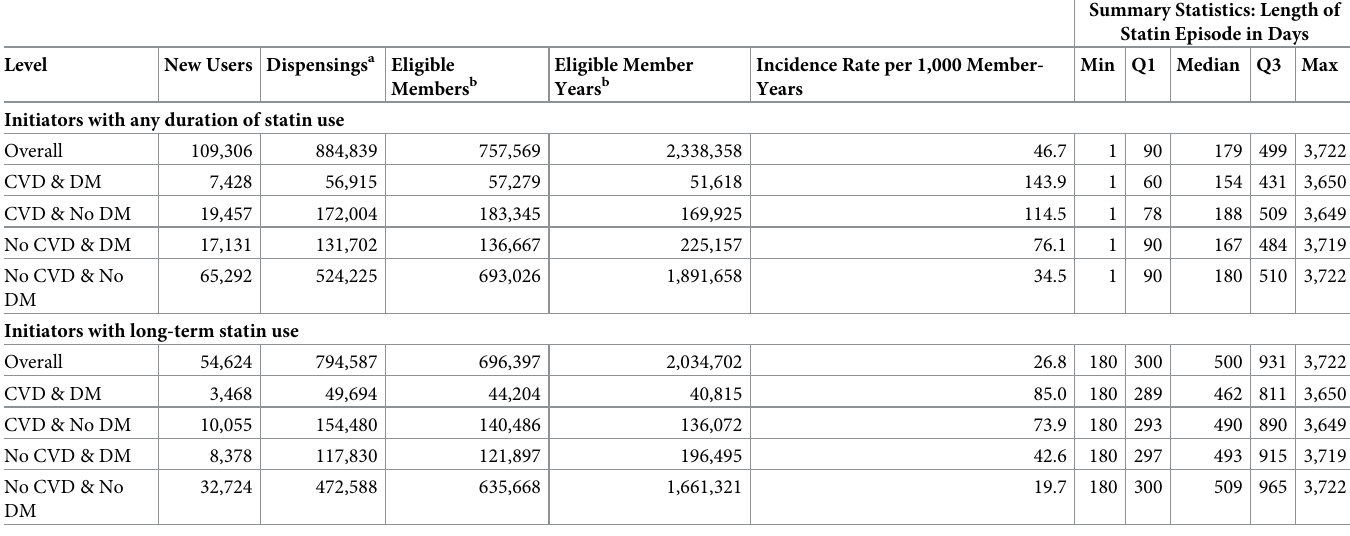
Table 1. Statin initiation among older adults aged > 75 years with and without cardiovascular disease and diabetes mellitus, NIH Collaboratory Distributed Research Database, January 1, 2008- March 31, 2018.